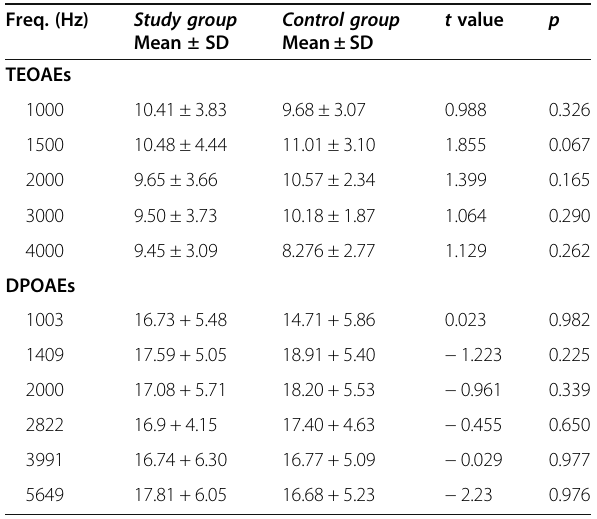
Table 4 Comparison between TEOAEs (absolute thresholds) and DPOAEs (signal to noise threshold levels) with contralateral suppression in study and control groups Freq. (Hz)